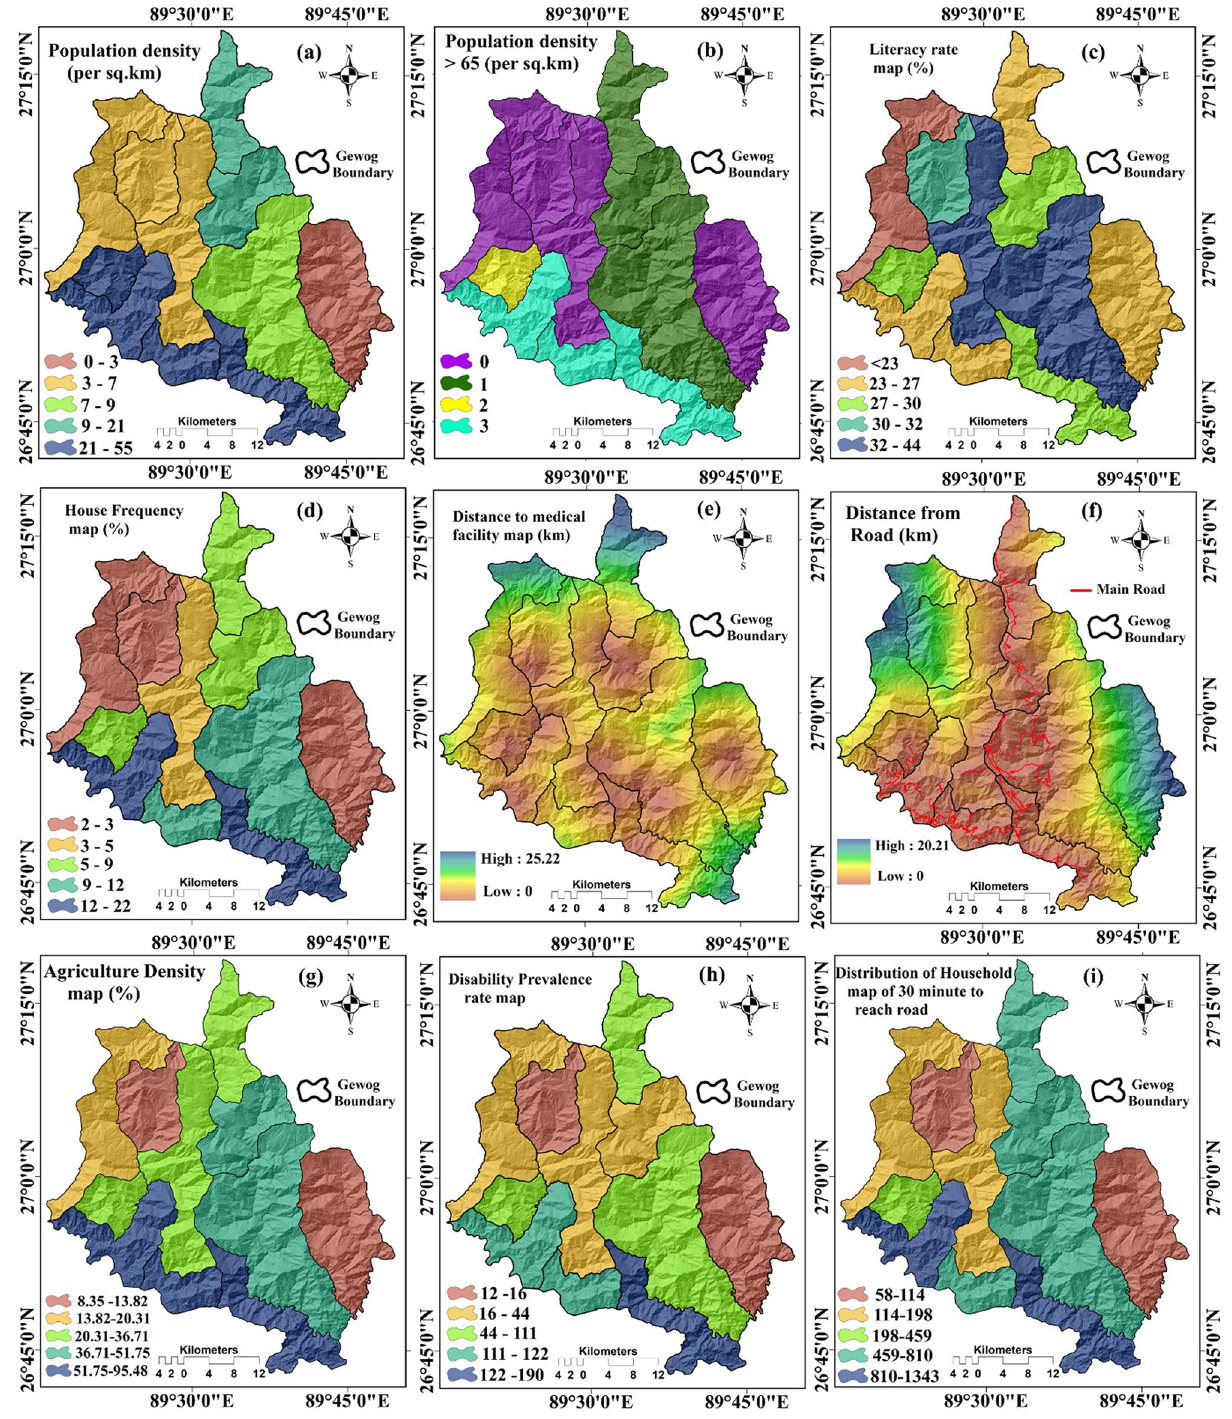
Figure 5. LVCFs used for producing the socio-economic landslide vulnerability maps: ( a ) Population density, ( b ) Old population density, ( c ) Literacy rate, ( d ) House frequency, ( e ) Distance to medical facility, ( f ) Distance to road, ( g ) Agriculture density, ( h ) Disability prevalence rate, ( i ) Household need 30 min to reach